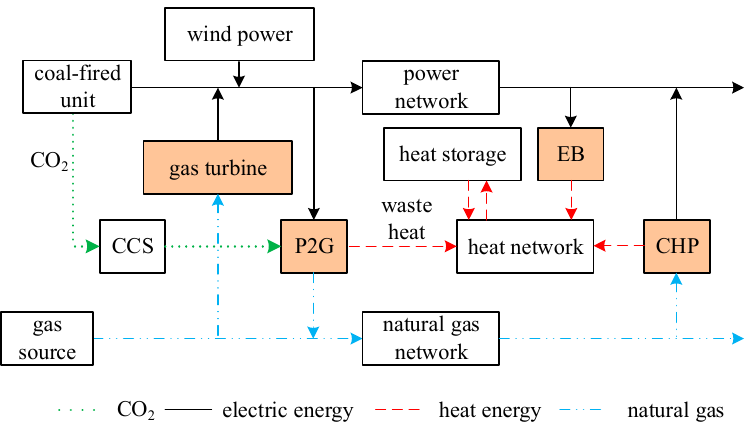
Figure 1. Model diagram of integrated energy system combined electricity, gas and heat.